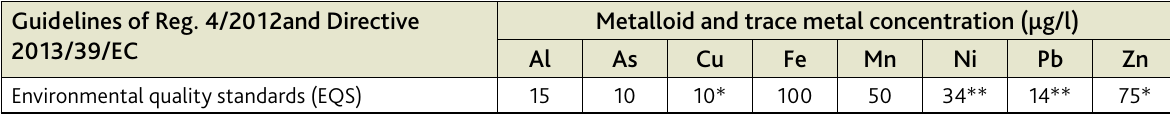
Table 4. Environmental quality standard for priority substances and some other pollutants Guidelines of Reg. 4/2012and Directive